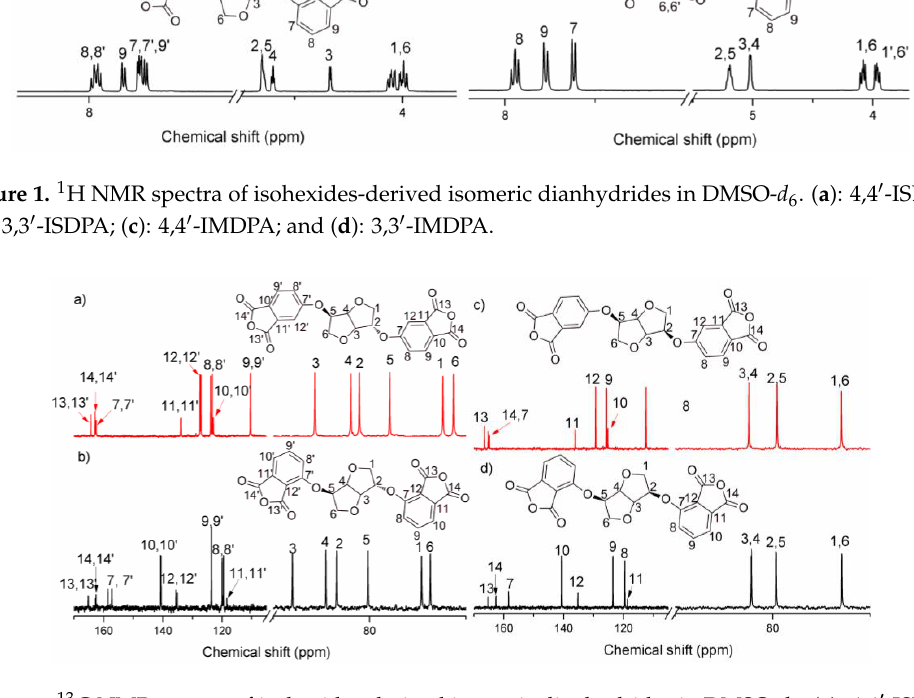
Figure 2. 13 C NMR spectra of isohexides-derived isomeric dianhydrides in DMSO- d 6 . ( a ): 4,4′-ISDPA; ( b ): 3,3′-ISDPA; ( c ): 4,4′-IMDPA; and ( d ): 3,3′-IMDPA.